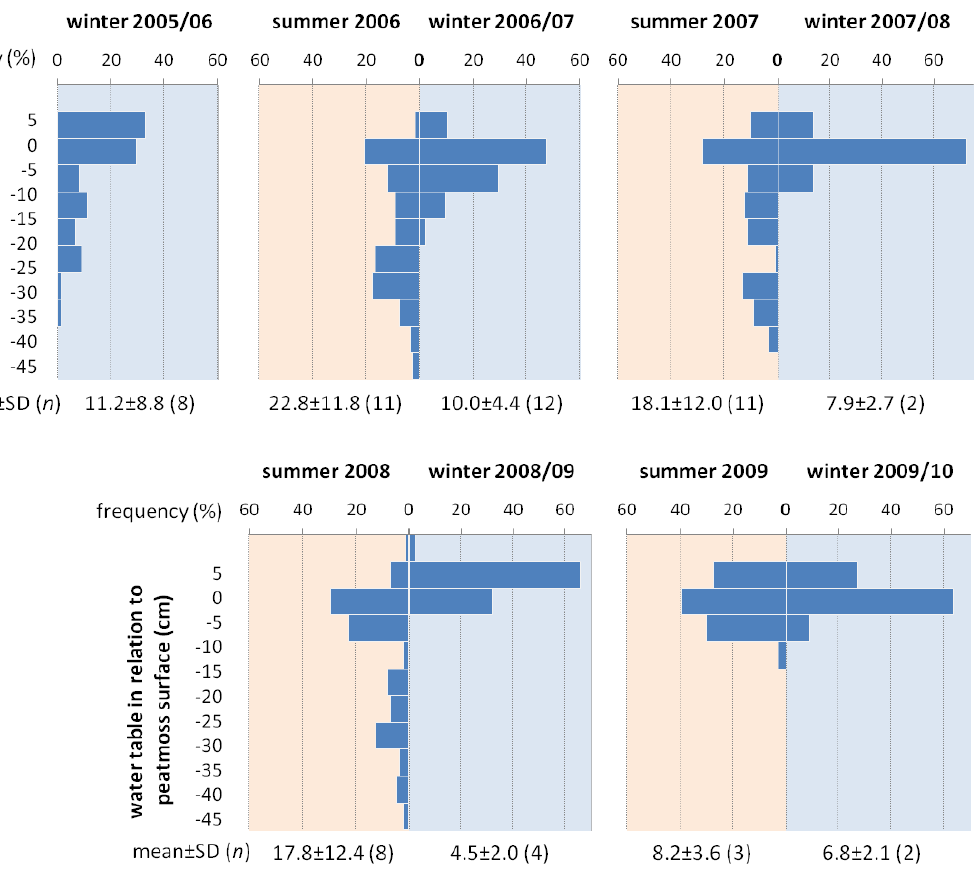
Figure 5. Water table frequency distribution (grouped into classes of 5 cm) and mean water table in relation to peatmoss surface in winter (October–March, blue) and summer (April–September, pink) for the period December 2005 to December 2009. Water table position was determined in eleven wells (see Figure 2a) on each observation date. The number of observations is given in brackets below each diagram.